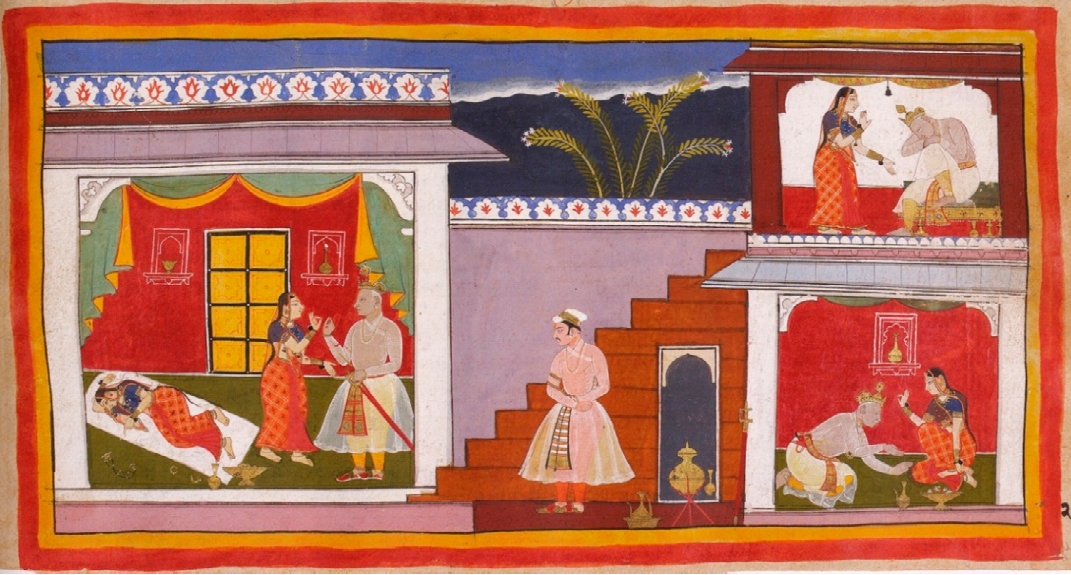
Figure 6. Kaikeyi Demands Her Boon , folio from Jagat Singh’s Ramayana manuscript, Mewar, ca.